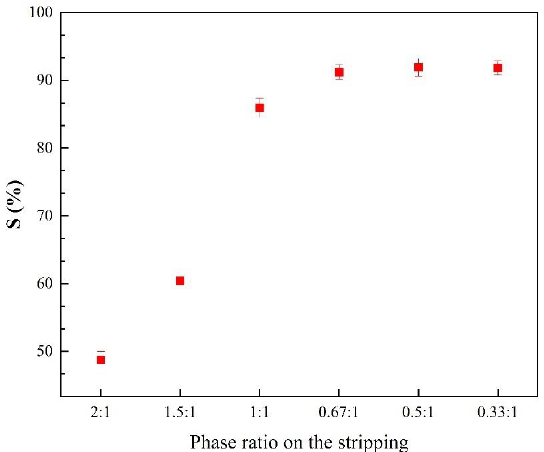
Figure 14. Effects of phase ratio on the stripping under the conditions: [oxalic acid] = 1 mol/L, stripping time = 40 min, and stripping temperature = 313 K.